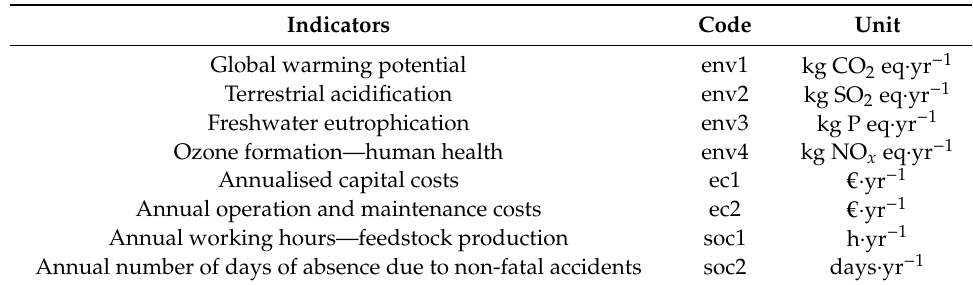
Table 2. Description of indicators included in the MCDA for prioritisation of wood-based residential heating